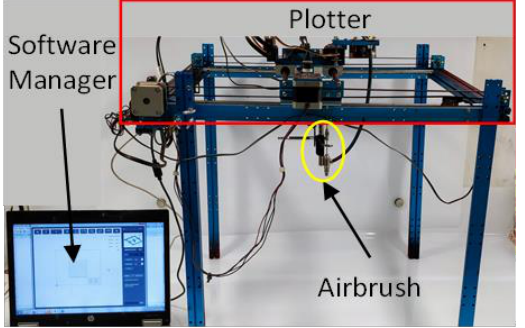
Figure 2. Set-up for the spray deposition of the GNP-based paint.